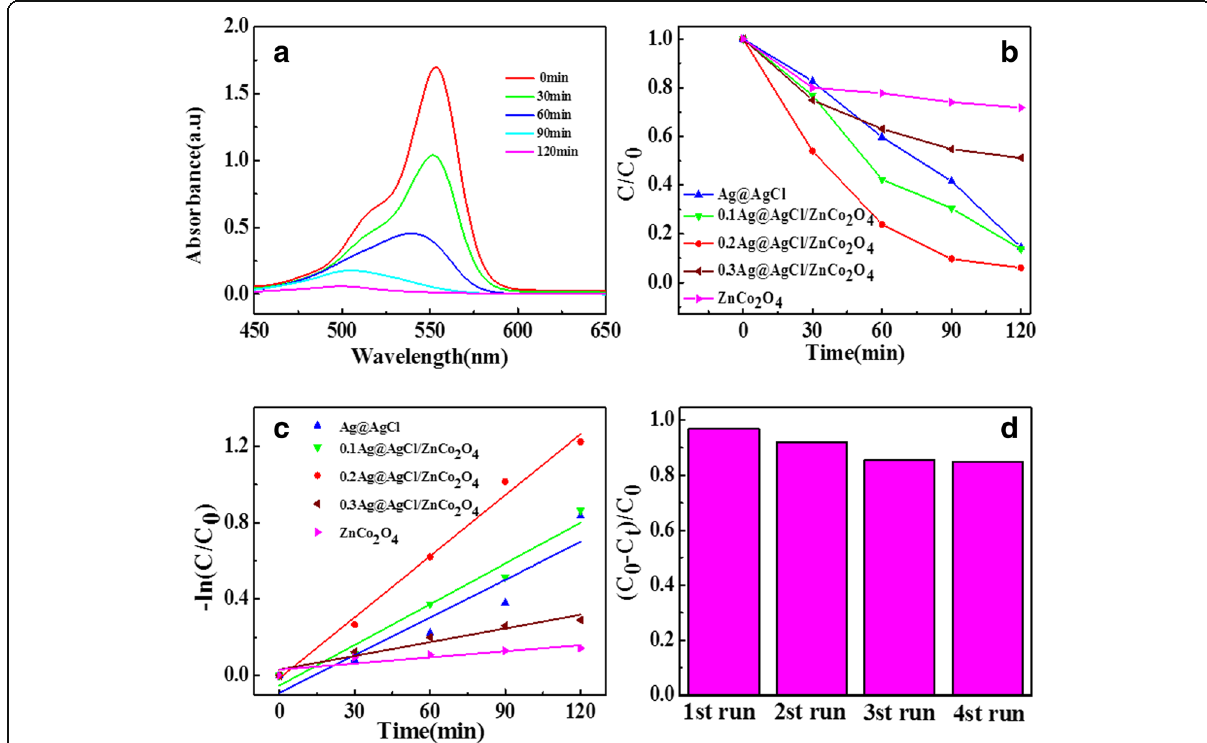
Fig. 6 a Visible light scanning pattern of 0.2Ag@AgCl/ZnCo 2 O 4 degradation of RhB. b Effects of different catalysts on photocatalytic degradation of RhB under visible light. c First-order kinetic fitting plots for degradation of RhB by different catalysts. d Cycling runs of 0.2Ag@AgCl/ZnCo 2 O 4 microspheres for the degradation of